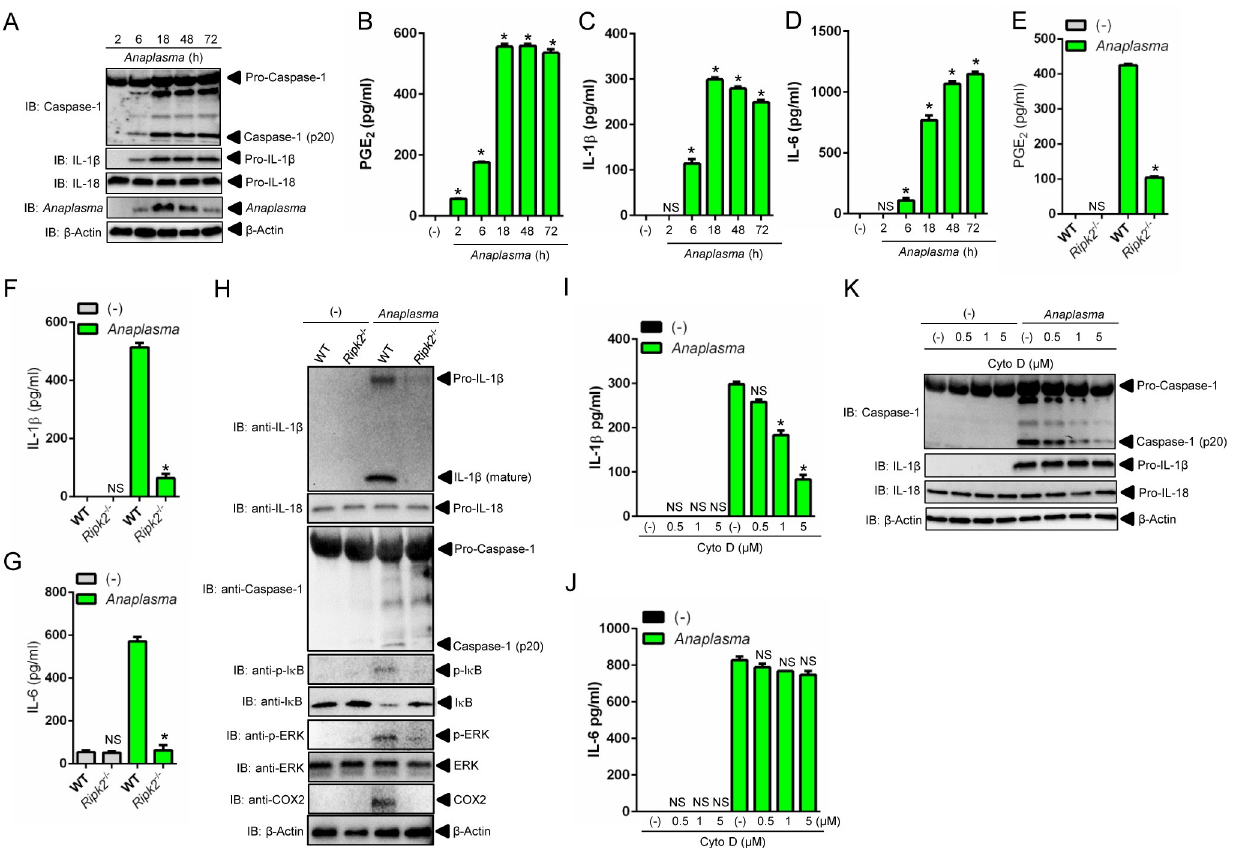
Fig 8. NLRC4 inflammasome activation is dependent on A . phagocytophilum internalization and RIPK2 function in macrophages. (A-D) Wildtype (WT) BMDMs (1 x10 6 cells) were infected with A . phagocytophilum (MOI 50). Cell culture supernatants and lysates were collected at indicated time points post-infection. (A) Caspase-1 autoproteolysis was detected in cell culture supernatants, whereas the presence of A . phagocytophilum , pro-IL-1 β , pro-IL-18 and β -actin are shown in cell lysates with SDS-PAGE immunoblots (IB). The levels of (B) PGE 2 , (C) IL-1 β and (D) IL-6 were measured in cell culture supernatants by ELISA. (E-G) BMDMs from WT and Ripk2 -/- mice were infected with A . phagocytophilum (MOI50) (1 x10 6 cells) for 18 hours. The levels of (E) PGE 2 , (F) IL-1 β and (G) IL-6 were measured in cell culture supernatants by ELISA. (H) Caspase-1 autoproteolysis was measured in cell culture supernatants, whereas pro-IL-1 β , pro-IL-18, p-I κ B, I κ B, p- ERK, ERK, COX2 and β -actin were detected in cell lysates by immunoblotting (IB). (I-K) WT BMDMs (1 x10 6 cells) were pre-treated with indicated concentrations of cytochalasin D for 30 minutes followed by A . phagocytophilum infection (MOI50) for 18 hours. The levels of (I) IL-1 β and (J) IL-6 in cell culture supernatants were measured by ELISA. (K) Caspase-1 autoproteolysis was detected in cell culture supernatants. pro-IL-1 β , pro-IL-18 and β -actin were detected in cell lysates with SDS-PAGE immunoblot (IB). One-way ANOVA-Tukey and Student ’ s t test. * P < .05; NS, not significant. (-) non-stimulated.